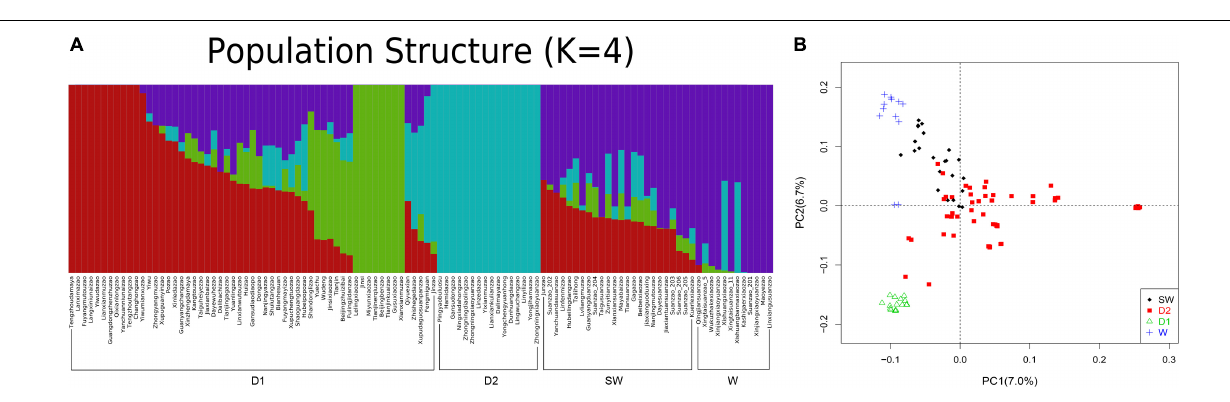
FIGURE 3 | Populational structure of 109 Ziziphus accessions. (A) ADMIXTURE plot of 109 Ziziphus accessions shows four subpopulations. (B) Principal component analysis (PCA) results for four subpopulations. “Linxiangusuanzao” in the wild subgroup is the genome assembly in this